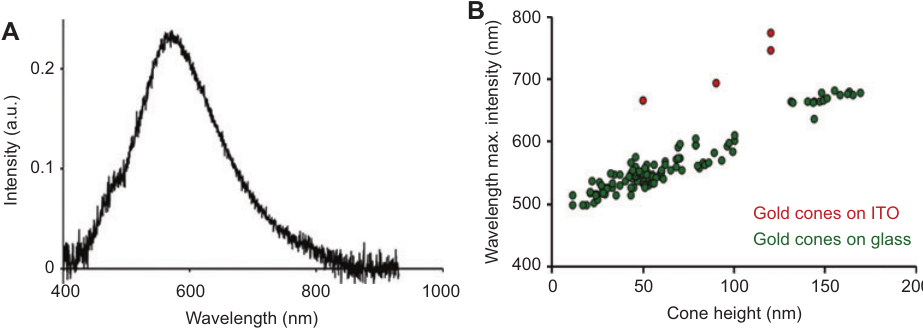
Figure 22 Dark-fi eld scattering spectroscopy of individual gold nanocones. (A) Resonance curve of a single 90 nm high, 95 nm base dia- meter nanocone. (B) The wavelength of maximum intensity of the dark-fi eld spectra is shifted across the visible spectrum for increasing cone height, with the function depending on the refractive index of the substrate material. Figures by M. Fleischer, measured at the Molecular Foundry, Berkeley, USA.